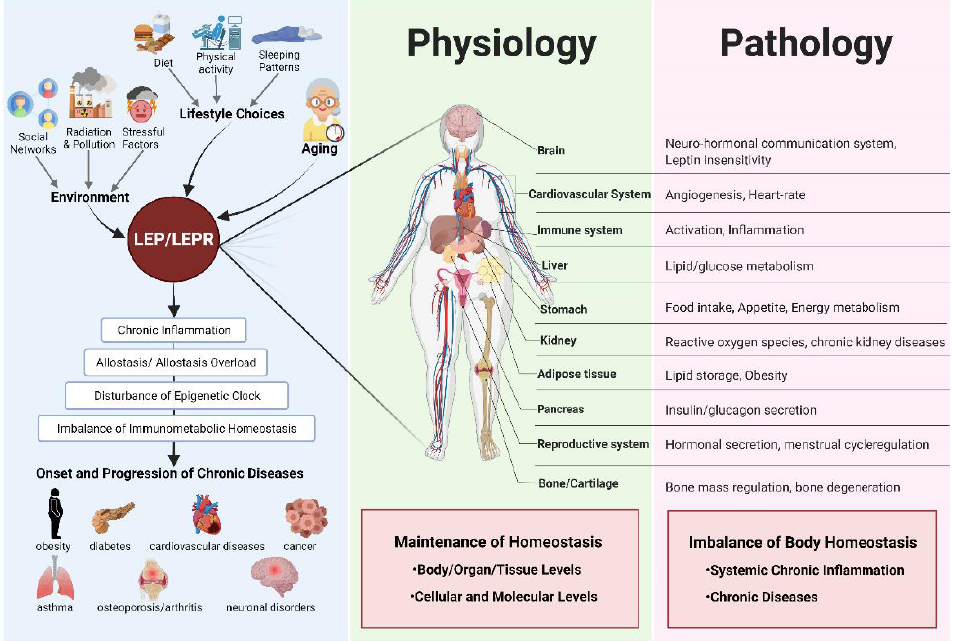
Figure 4. An overview of the key roles of “leptin switch” in homeostasis disturbance and pathophysiology of complex diseases.